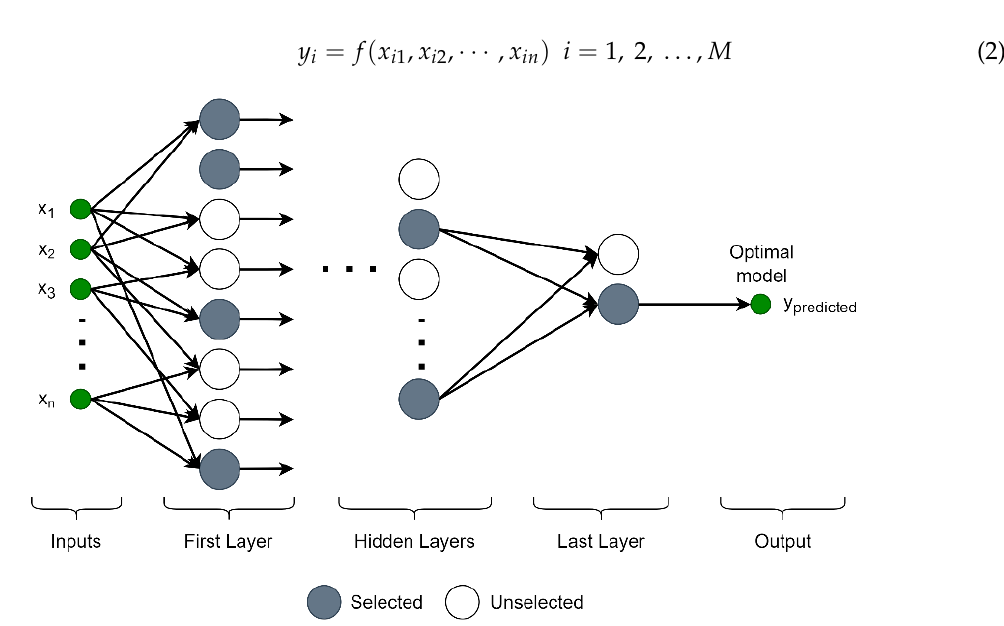
Figure 2. The schematic representation of GMDH-type NN.